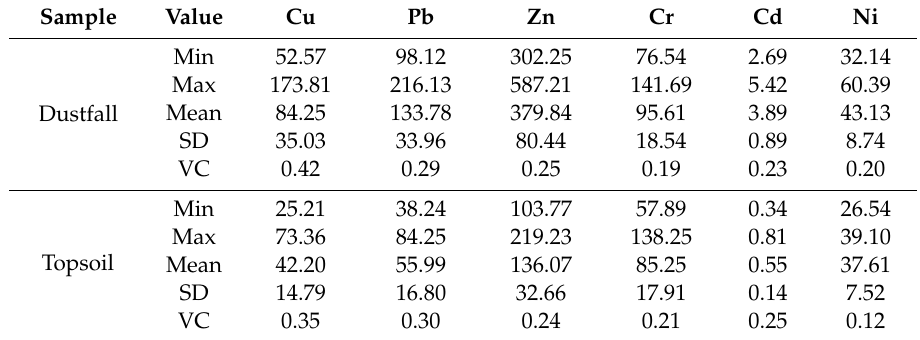
Table 2. The concentrations of heavy metals in atmospheric dustfall and topsoil in Lanzhou (mg · kg − 1 ).